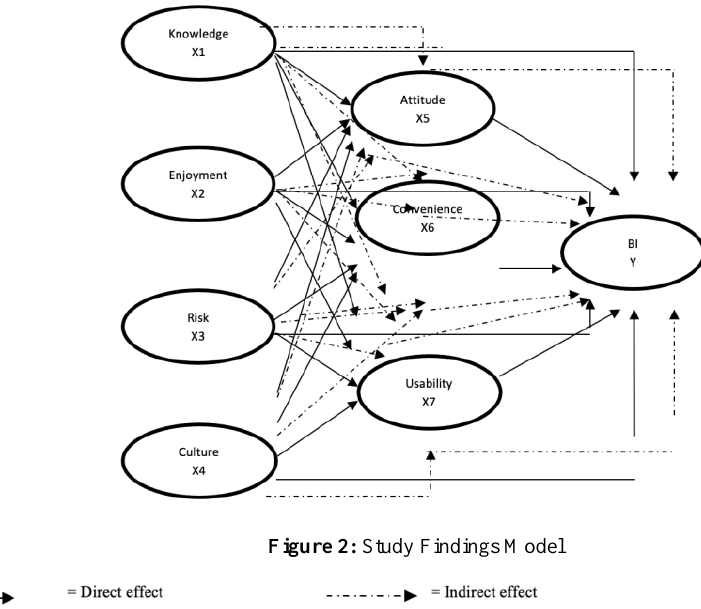
Figure 2: Study Findings